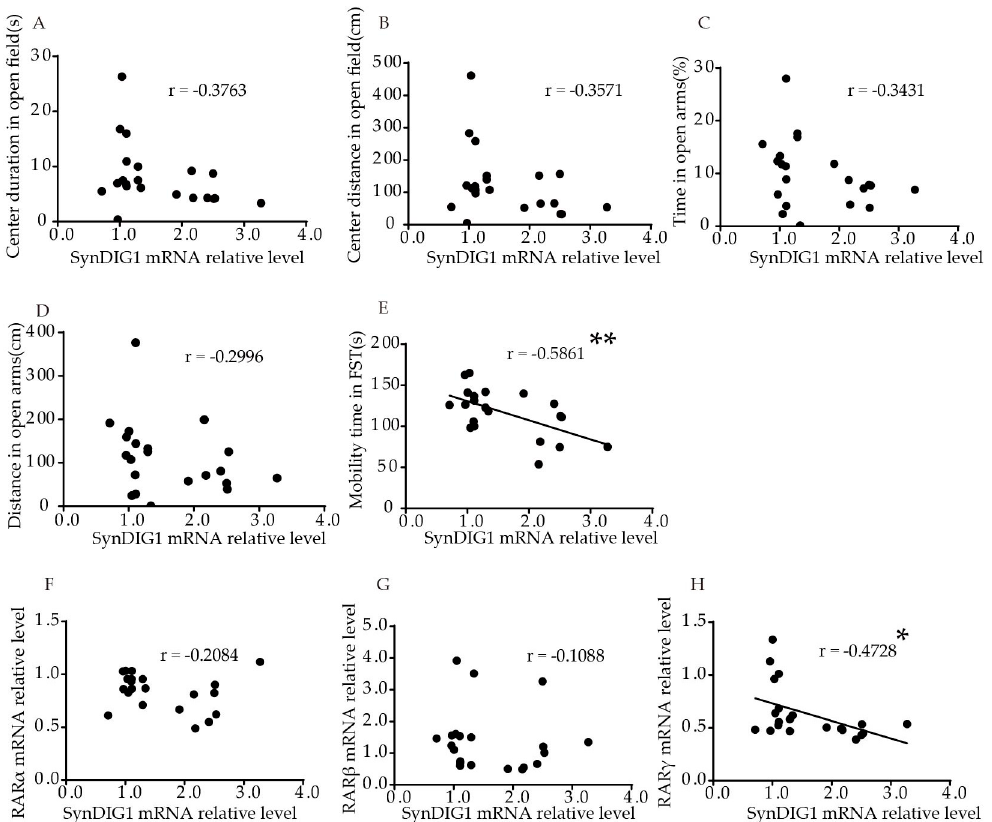
Figure 5. Correlation of the SynDIG1 mRNA levels in the hippocampus with behavior and RARs mRNA levels in young mice. Correlation between mRNA levels of SynDIG1 in the hippocampus and ( A ) center duration, ( B ) center distance in OFT, ( C ) duration, and ( D ) distance in the open arms in EPM, ( E ) mobility time in FST. Correlation between mRNA levels of DLG2 in the hippocampus and ( F ) RAR α , ( G ) RAR β , and ( H ) RAR γ . Correlation analysis was performed using Pearson’s correlation test. * p < 0.05, ** p < 0.01.